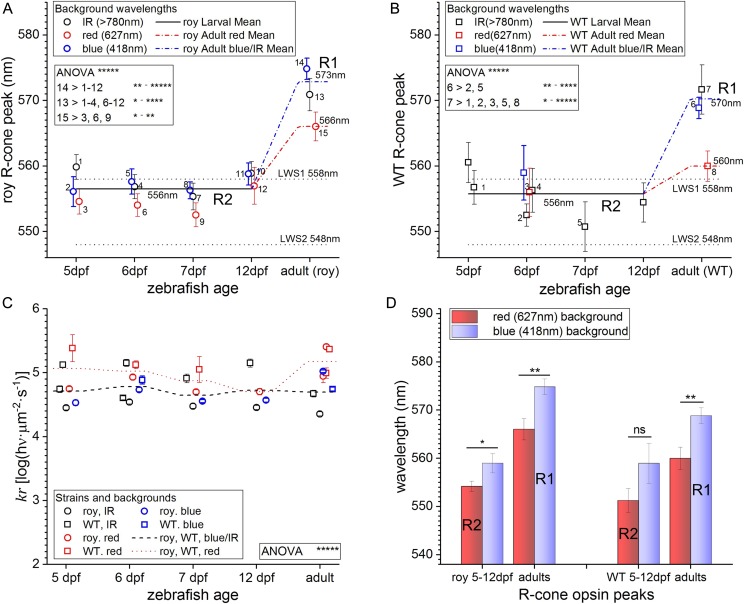
Developmental shift from R2 to R1 cones in the red-waveband (530–630 nm). (A, B) R-cone wavelength peaks (±s.e.) are calculated by fitting treatment-level datasets from many eyes at each age and background wavelength to eqn. (3). Results are compared with the 558-nm LWS1 and 548-nm LWS2 opsin peaks in solution (dotted lines) (Chinen et al., 2003), with the 5–12 dpf larval (R2-cone) means (solid lines), and with the adult (R1) cone means on red (627 nm) vs. combined blue (418 nm) and IR (λ > 780 nm) backgrounds (red and blue dash-dot lines respectively). (A) R-cone peaks for the roy strain differed with age and background [ANOVA, F(14, 19,375) = 8.42, P < 0.00001, eyes = 113]. All 26 significant Tukey post hocs (0.05 > P < 0.00001) paired a shorter-wavelength larval R2 peak with a longer-wavelength adult R1 peak. The larval mean fit value was 556.5 ± 0.6 nm [s.e., n = 12 normalized treatment-level datasets ranging from 700 to 1960 points each, including red, blue and IR backgrounds]. The mean adult R2-cone peak on IR and blue backgrounds was 572.9 ± 2.0 nm (s.e., n = 2 treatment-level datasets, 770 and 2100 points) and on red background, 566.0 ± 2.5 nm (s.e., 1 treatment-level dataset, 980 fit points). (B) WT R-cone wavelength peaks depend on developmental stage and background illumination [ANOVA, F(10, 10,210) = 6.1, P < 0.00001, eyes = 79]. All seven significant post hoc pairs found a larval R2 peak at shorter wavelengths than an adult R1 (Tukey, 0.05 > P < 0.00001).The larval R2 mean fit value was 555.8 ± 1.1 nm (s.e., n = 8 larval treatment-level datasets, ranging from 210 to 1858 data points, including red, blue, and IR backgrounds). The mean adult R2 peak (blue and IR backgrounds) was 570.3 ± 1.4 nm (s.e., two treatment-level datasets, 1469 and 1400 points) and on a red background, 560.0 ± 2.3 nm (s.e., one treatment-level dataset, 1258 points). (C) R-cones are high semisaturation types at all ages in both WT and roy. Semisaturations differed (ANOVA, see text), but without developmental trend. Lines show minimal age variations on red backgrounds (red dots) or blue and IR combined backgrounds (black dashes). Semisaturation on red backgrounds is greater (see text). (D) R-cone peaks shift to shorter wavelengths on red backgrounds as compared with blue. Larval R2 cone peaks are fits to composite 5–12-dpf treatment-level datasets on 627 nm background (roy, 5040 points; WT, 939 points) or 418 nm background (roy, 4060 points; WT, 210 points). In roy larvae and adults, and WT adults, the wavelength shift is significant (t-tests, see text). The red-background, short-wavelength shift suggests mixtures of R1 and R2 cones in both larvae and adults, with R2 dominant in larvae and R1 in adults.